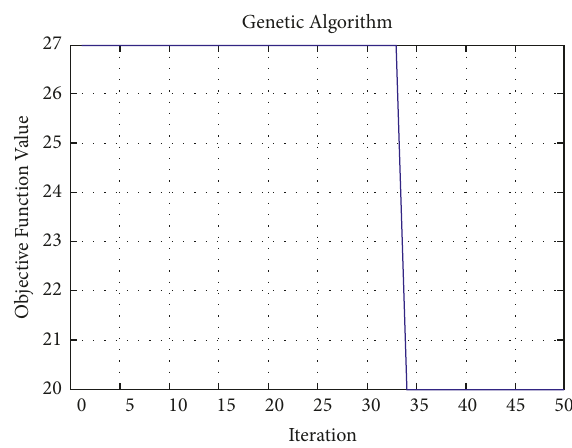
Figure 3: Optimality of the objective function by increasing the number of iterations in the genetic